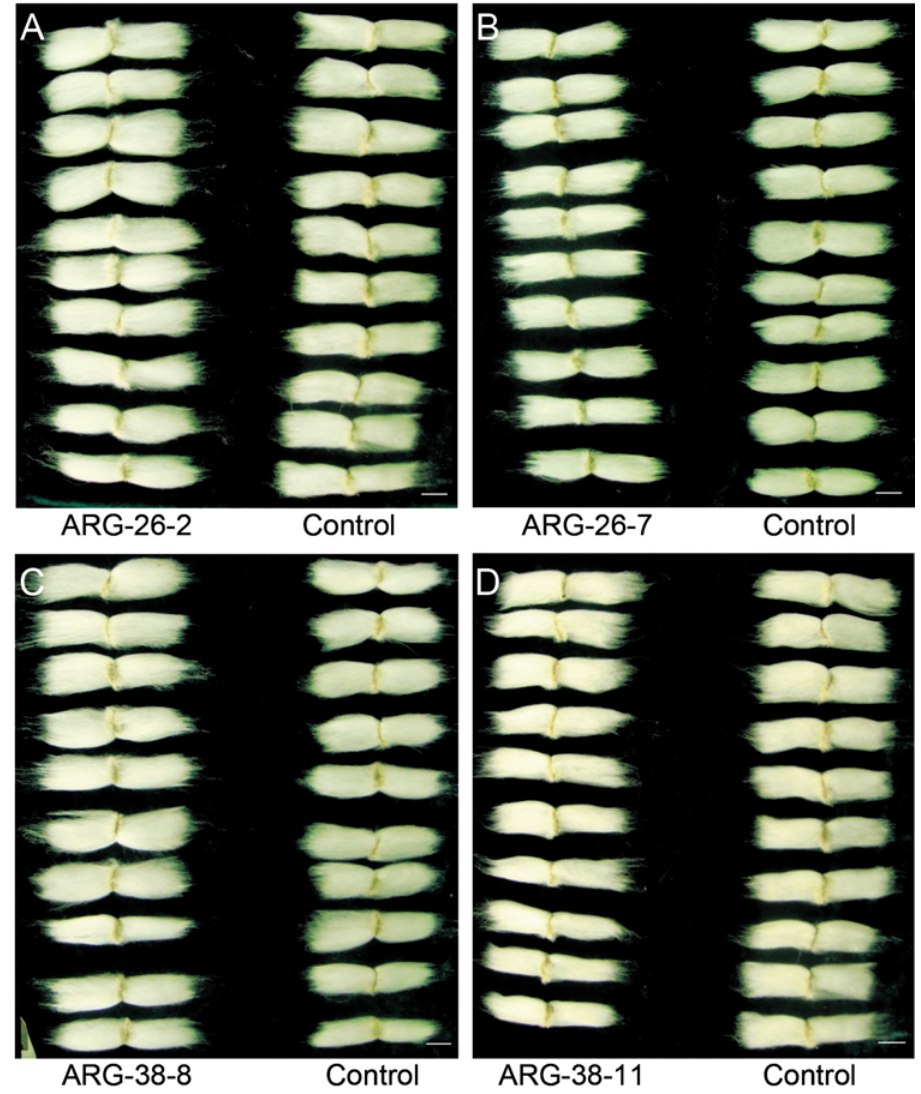
Fig 10. Fiber lengths of transgenic cotton are compared with Control. (A) the fiber length of ARG-26-2 compared with that of the Control. (B) the fiber length of ARG-26-7 compared with that of the Control. (C) the fiber length of ARG-38-8 compared with that of the Control. (D) the fiber length of ARG-38-11 compared with that of the Control. ‘ Control ’ refers to fiber of non-transgenic wild type plants. Scale bar, 5mm.